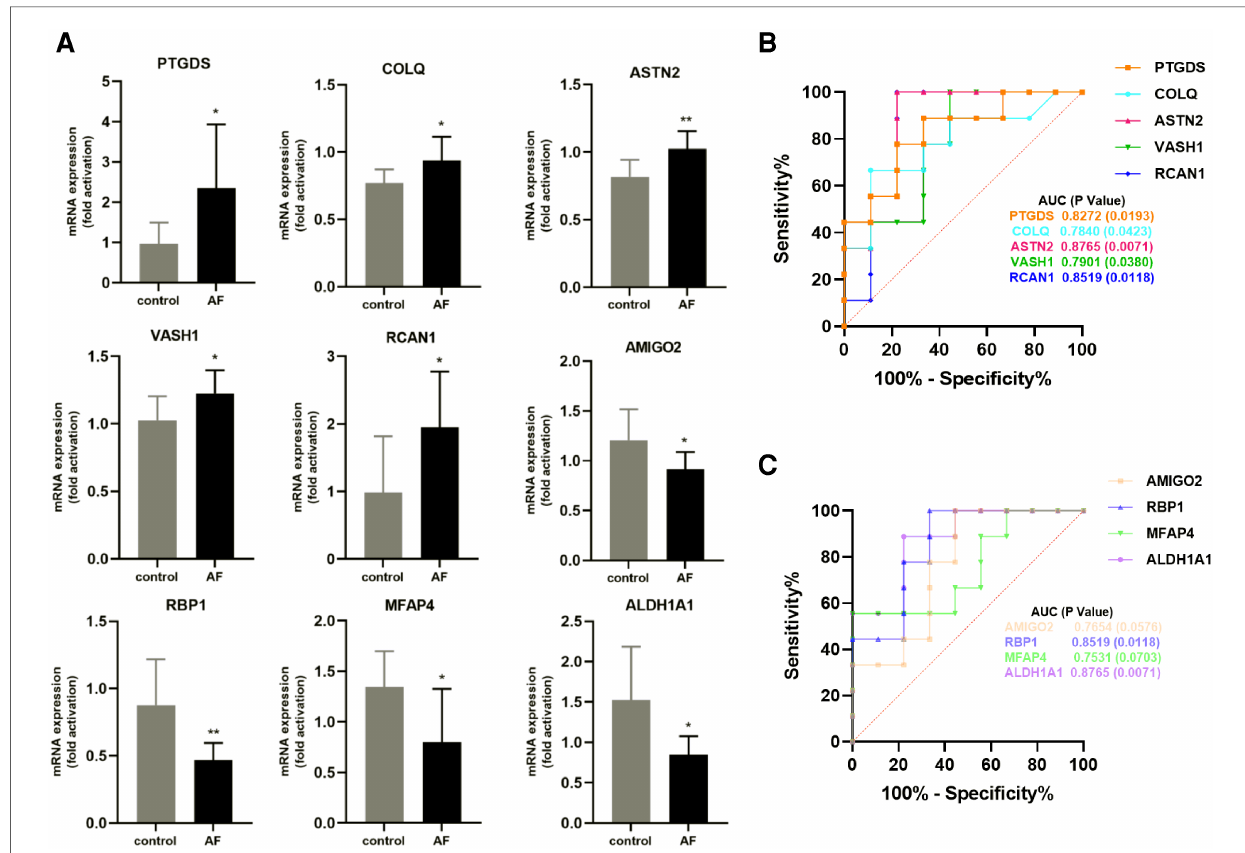
FIGURE 8 Validation of hub genes in human peripheral blood leukocytes. ( A ) Relative mRNA expression level of nine hub genes in AF patients and controls (* P < 0.05, ** P <0.01). ( B ) ROC curve for fi ve hub genes from the green module. ( C ) ROC curve for four hub genes from the pink